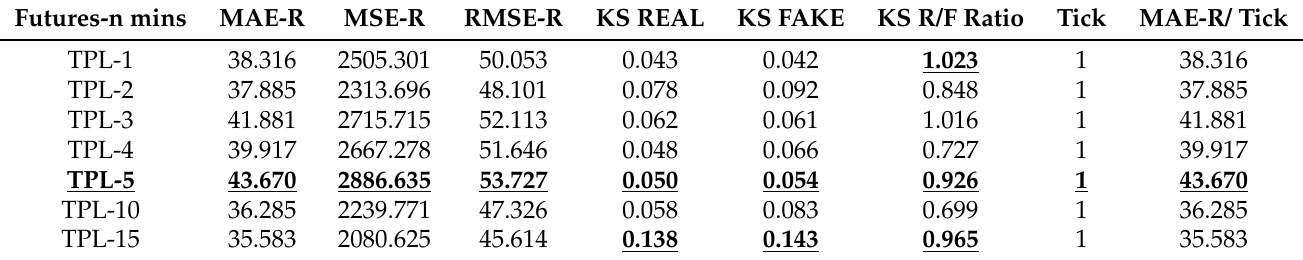
Table 6. TPL-n mins (TOCOM platinum) represent futures contracts listed in JPX at one, two, three, four, five, ten and fifteen minutes intervals. For KS R/F Ratio, 2 out of 7 are bigger than one, where the highest KS REAL and FAKE are 0.138 and